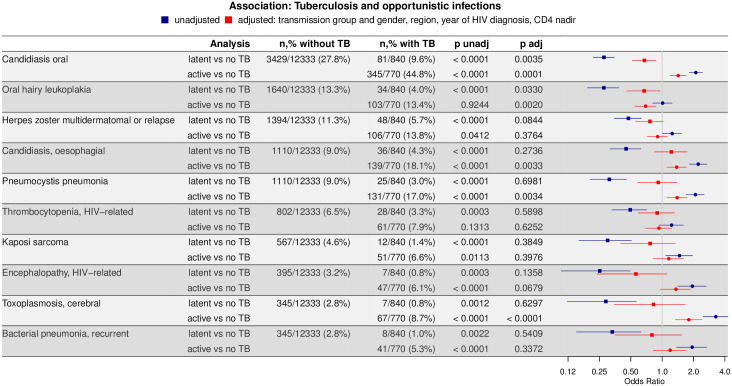
Association of the 10 most frequent OIs with TB infection: Patients with active TB and LTBI compared to MTB uninfected patients, respectively (active TB versus no TB, latent versus no TB).The lines indicate the 95% CIs obtained through the logistic regression model; the dots indicate the ORs. (see S3 Data for the underlying numerical values) CI, confidence interval; LTBI, latent tuberculosis infection; MTB, Mycobacterium tuberculosis; OI, opportunistic infection; OR, odds ratio; TB, tuberculosis.